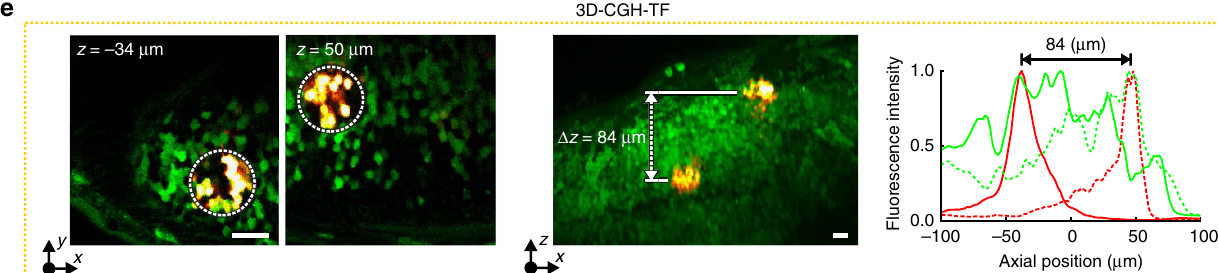
Figure 5 | 3D simultaneous 2P photoconversion of Kaede in vivo . ( a ) Merged brightfield and widefield fluorescence images of a double transgenic Tg(HuC:gal4; UAS:kaede) zebrafish larvae. Red and blue squares represent the approximate areas where we performed photoconversion. Scale bar, 400 m m. ( b ) Left, overlaid green and red HiLo fluorescence images before and after photoconversion, respectively. Right, orthogonal maximum red fluorescence intensity projection showing 14 photoconverted neurons on a single axial plane (illumination density 0.4mW m m (cid:2) 2 , 200 pulses of 50ms). Scale bars, 60 m m. ( c ) Orthogonal maximum fluorescence intensity projection of overlaid HiLo pre- and post-photoconversion images (green and red fluorescence, respectively). Three single cells were photoconverted on separated axial planes (4.0mW m m (cid:2) 2 , one pulse of 200ms). Scale bar, 60 m m. ( d ) Simultaneous 3D photoconversion of neural ensembles in the spinal cord. Left, overlaid HiLo pre- and post-photoconversion fluorescence images, where three 35- m m-diameter holographic spots projected at z ¼ (cid:2) 18 m m, 3 and 18 m m were used for photoconversion (0.03mW m m (cid:2) 2 , 2,000 pulses of 50ms). Right, axial distributions of green pre- and red post-photoconversion integrated fluorescence intensity over z for the spots projected at the three different planes. Scale bars, 60 m m. ( e ) Simultaneous 3D photoconversion of neural ensembles in the zebrafish brain. Left, overlaid 2P-excited green- and red post-photoconversion fluorescence images, where two 35- m m-diameter holographic spots projected at z ¼ (cid:2) 38 m m and 50 m m were used for photoconversion (0.11mW m m (cid:2) 2 , 9,000 pulses of 50ms). Scale bar, 20 m m. Middle, Orthogonal maximum 2P-excited fluorescence intensity projection of overlaid green and red-post-photoconversion images. Scale bar, 20 m m. Right, axial distributions of green pre- and red post-photoconversion integrated 2P fluorescence intensity over z for the spot at z ¼ (cid:2) 38 m m (solid lines) and the one at z ¼ 50 m m (dotted lines). z -values in all cases are given as distances from the focal plane of the objective, which for the spinal cord experiments was at B 60 m m and for the brain at B 90 m m from the fish surface (where green fluorescence was starting). Positive z -values are closer to the surface. l phot ¼